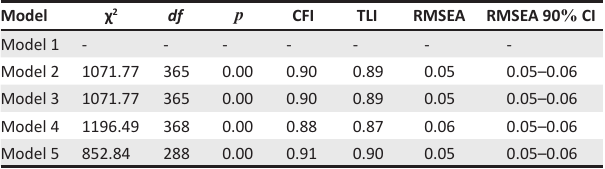
TABLE 2: Fit statistics for the competing measurement